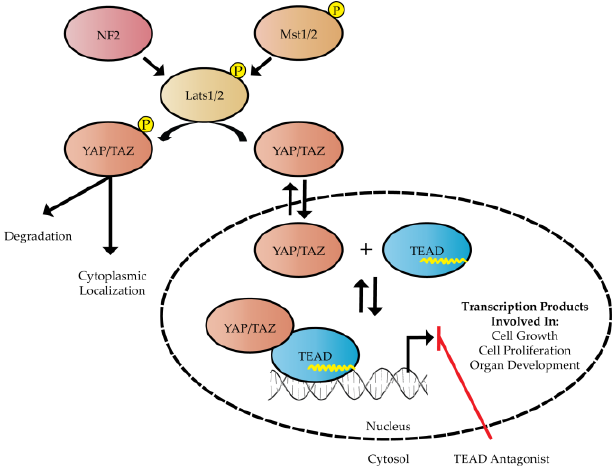
Figure 1. The Hippo signaling pathway is composed of neurofibromin 2 (NF2), mammalian STE20-like protein kinase 1/2 (Mst1/2) and large tumor suppressor 1/2 (Lats1/2). NF2, Mst1/2, and Lats1/2 are represented as red, orange, and brown ellipsoids, respectively. Phosphorylation of either Yes-associated protein (YAP) or transcriptional co-activator with PDZ-binding motif (TAZ) by Lats1/2 affects nuclear translocation of YAP/TAZ. Transcription of DNA can be activated by palmitoylated transcriptional enhanced associate domain (TEAD) in the presence of YAP/TAZ. The palmitate group is illustrated as a yellow line within the blue ellipsoid representing TEAD. A TEAD antagonist could serve as a useful strategy for altering the TEAD-YAP transcriptome in various cancer cells.